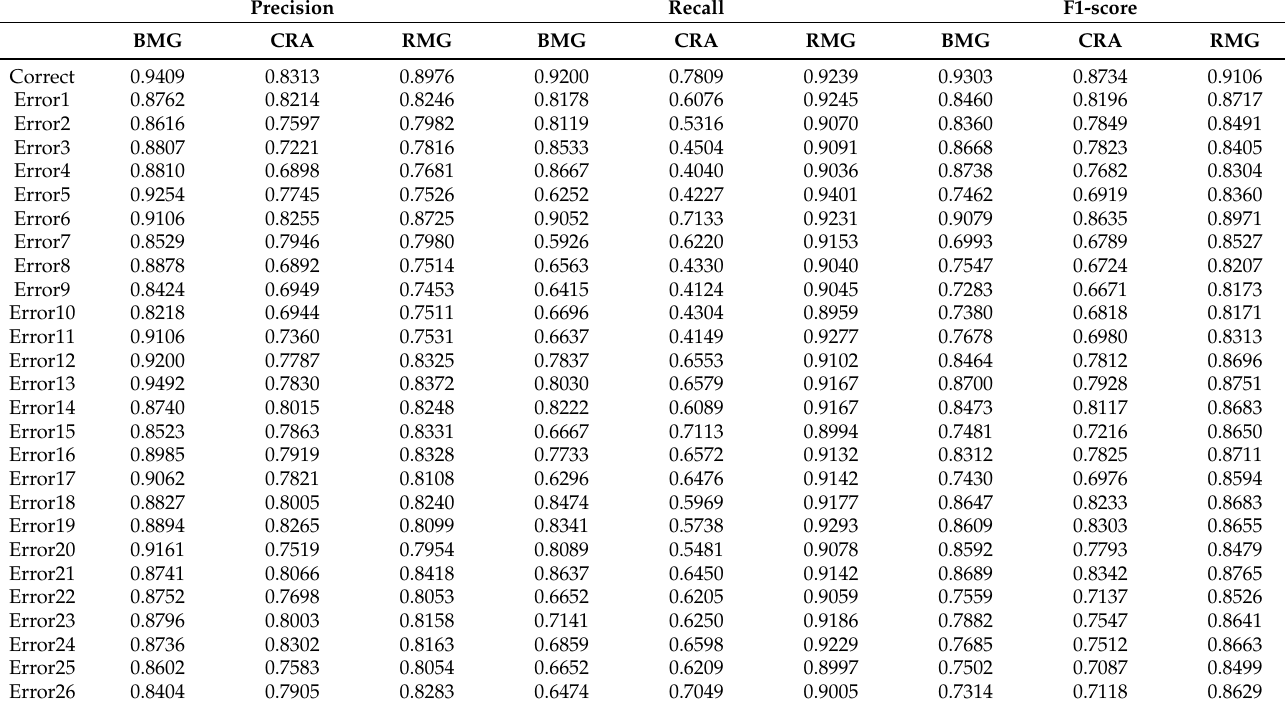
Table A2. F1-score, Recall, and Precision of different cost